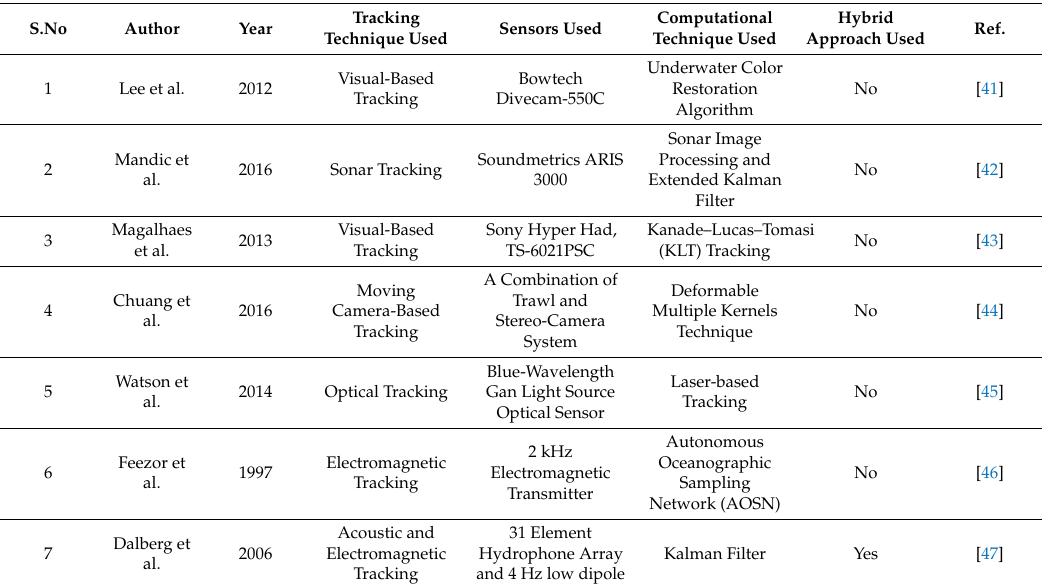
Table 6. Di ff erent techniques of underwater object